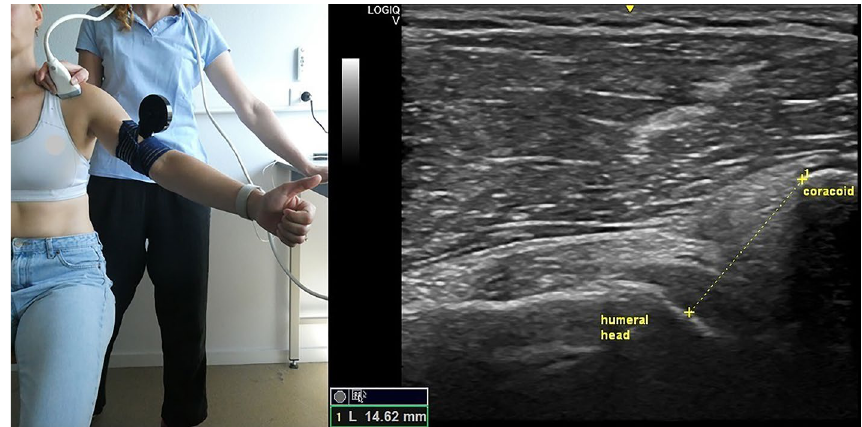
Figure 4. Left: position of the probe and of the subject during the measurement of the coracohumeral distance at 60°; right: measurement of the coracohumeral at 60°. Photo on the left side by Anthe Foubert.